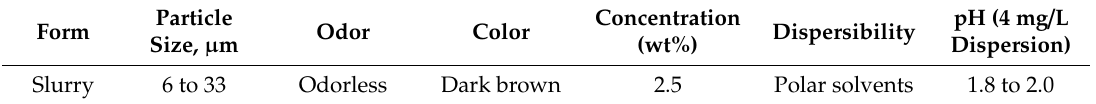
Table 3. Physical properties of graphene oxide [58].